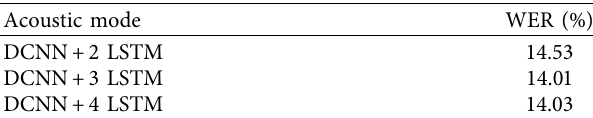
Table 5: Results with LSTM of different layers on